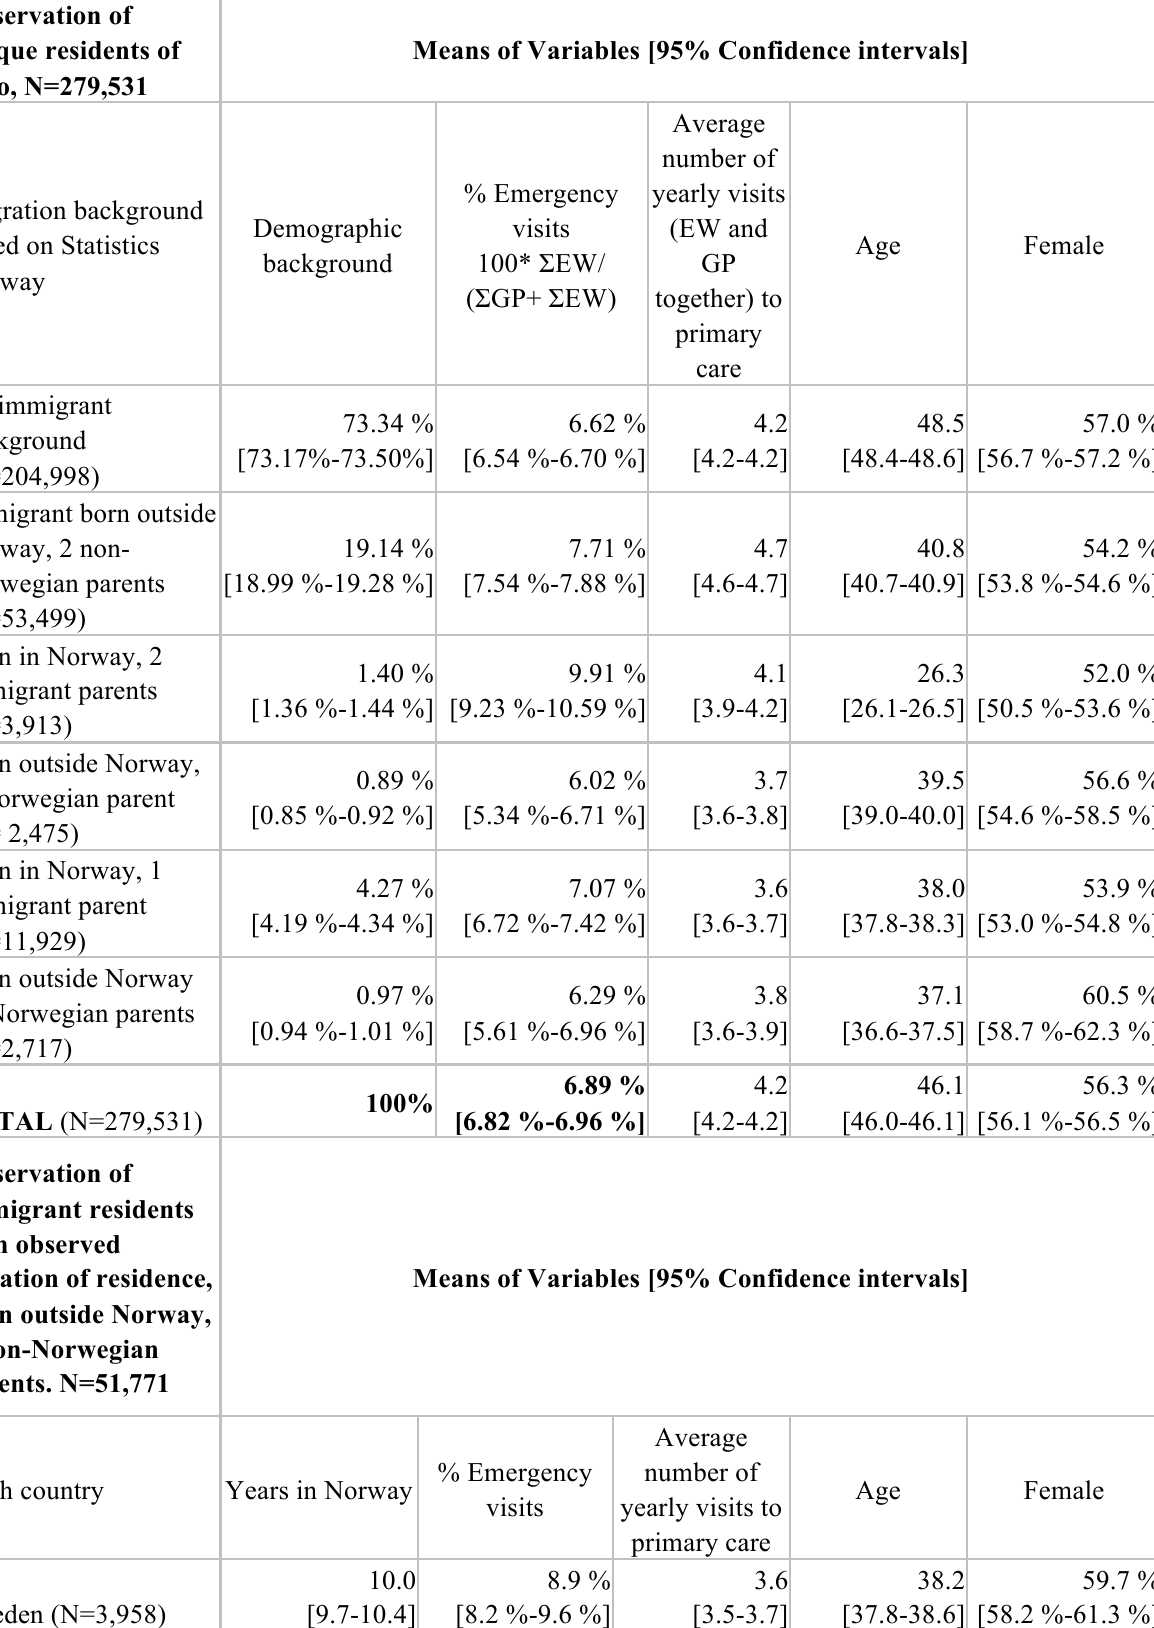
Table 1: Use of emergency services according to background for residents of Oslo based on data collection in a 2-year period 2006-2007. Observation